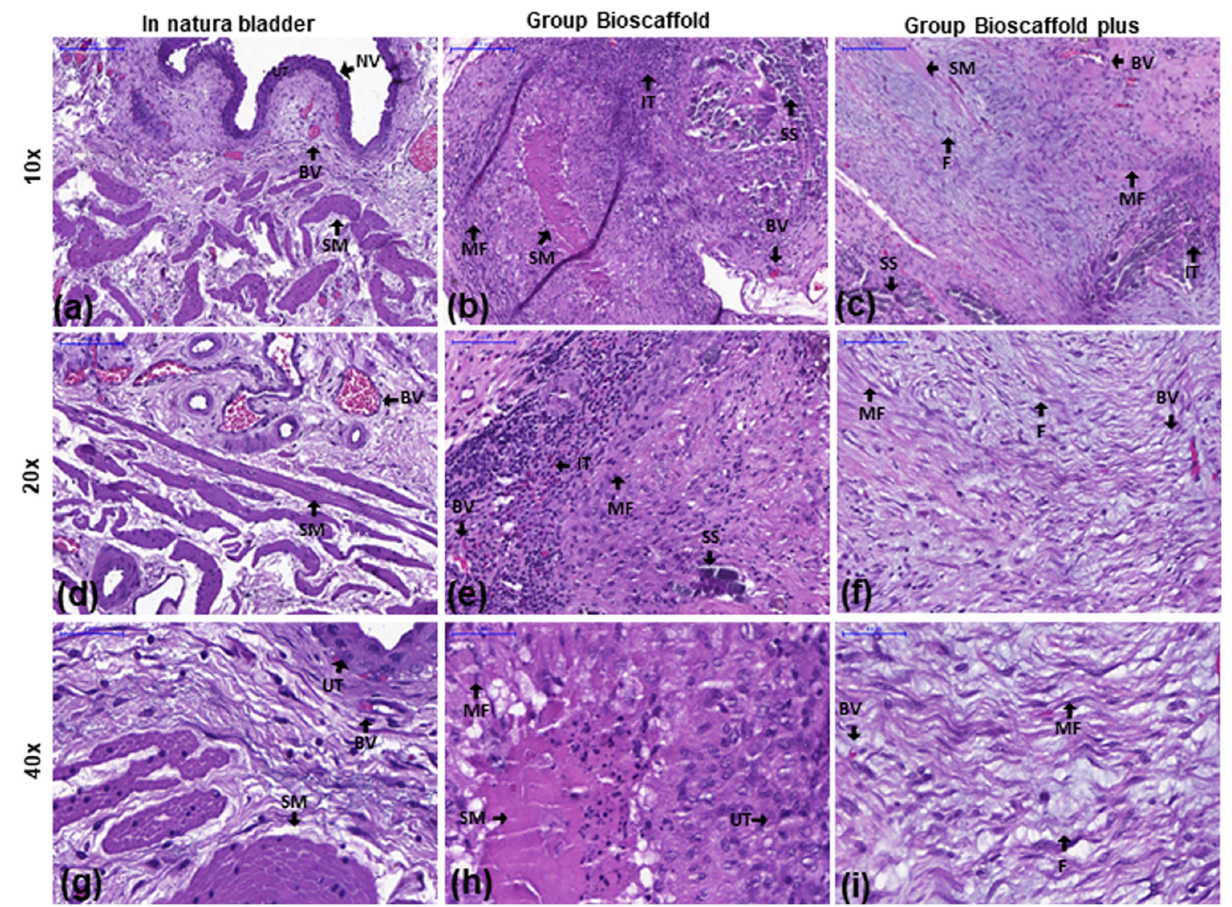
Figure 3. Inflammatory infiltration analysis of the urinary bladder by hematoxylin and eosin stains at three magnifications. Groups: In natura ( a , d , g ): Urothelium with normal structure and normal- looking villi (NV). Bioscaffold alone ( b , e , h ): Infiltrating inflammatory tissue (IT) and immature myofibroblasts (MF) were observed in the submucosa near the wound. Bioscaffold group with ASCs ( c , f , i ): Urothelium with normal structure and infiltrating inflammatory tissue (IT). Mature fibroblasts (F) were observed in the submucosa close to the wound. Blood vessels (BV) were observed in the region equivalent to the vesical mucosa/submucosa transition. Key: blood vessel (BV), smooth muscle (SM), myofibroblasts (MF), urothelium (UT), infiltrating tissue (IT, with macrophages, lymphocytes, eosinophils, plasmocytes, and neutrophils), surgery stitches (SS), normal-looking villi (NV), mature fibroblasts (F). Magnification: Top row: 10 × ; Middle row: 20 × ; Bottom row: 40 × . Table 2. Analysis of post-surgical repair